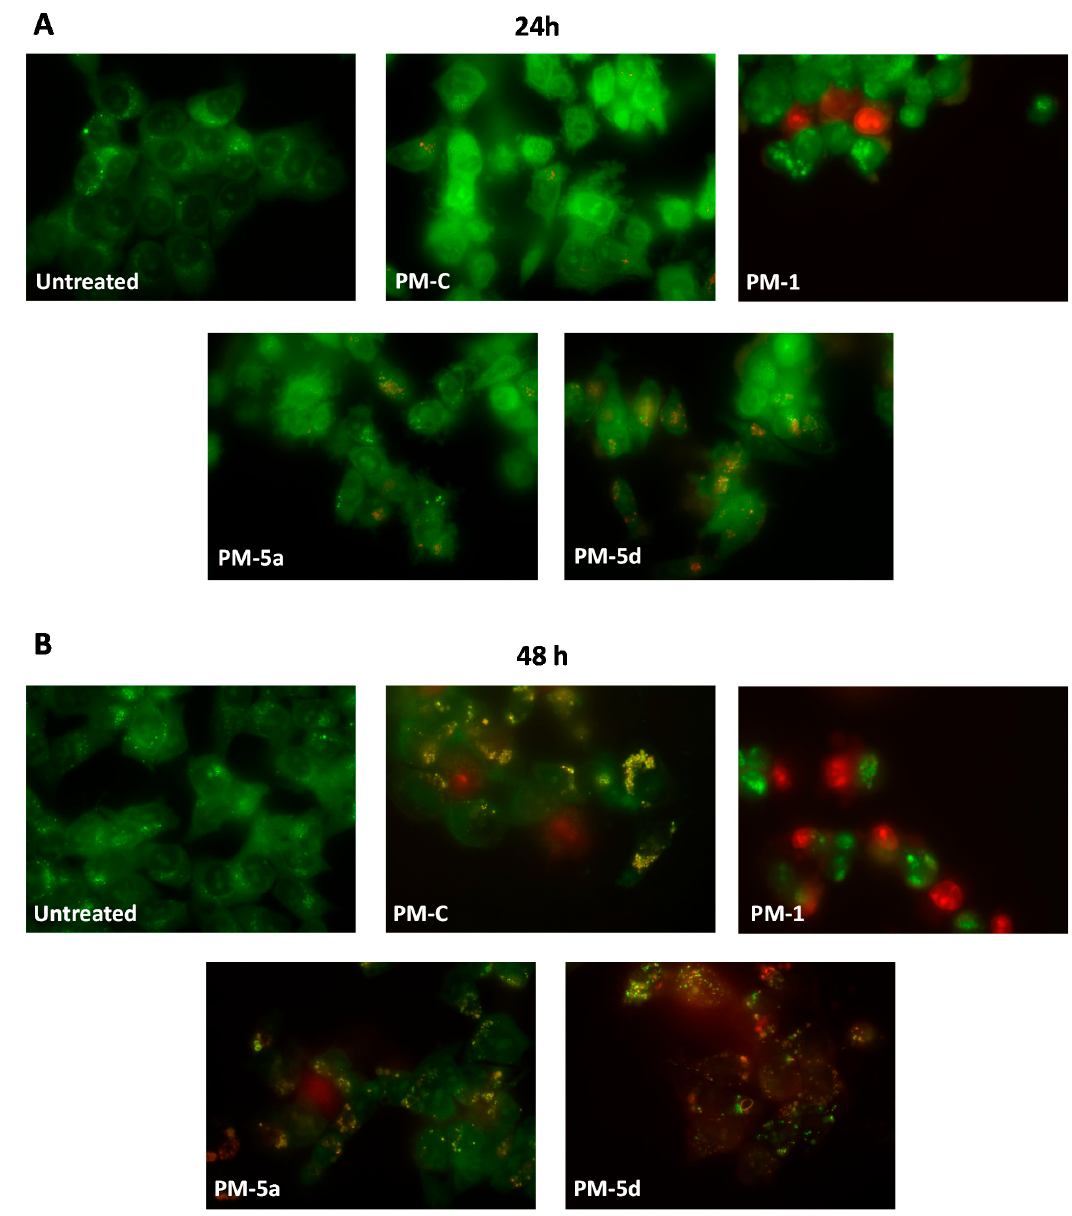
Figure 6. Fluorescence micrographs of HCT116 cells treated for 24 h and 48 h with PMs at IC 50 after AO/EB double staining. Magnification 630×. Viable cells are uniformly stained in green, without nuclear alteration. Necrotic cells are intensely and uniformly stained in red, showing an increased cytoplasmic volume, while the apoptotic cells are green stained with bright orange or uniformly orange stained with condensed and/or fragmented nuclei.